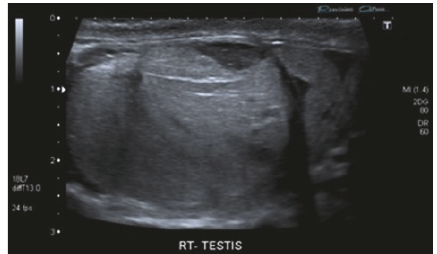
Figure 1: Fractured right testicle on ultrasound scan.